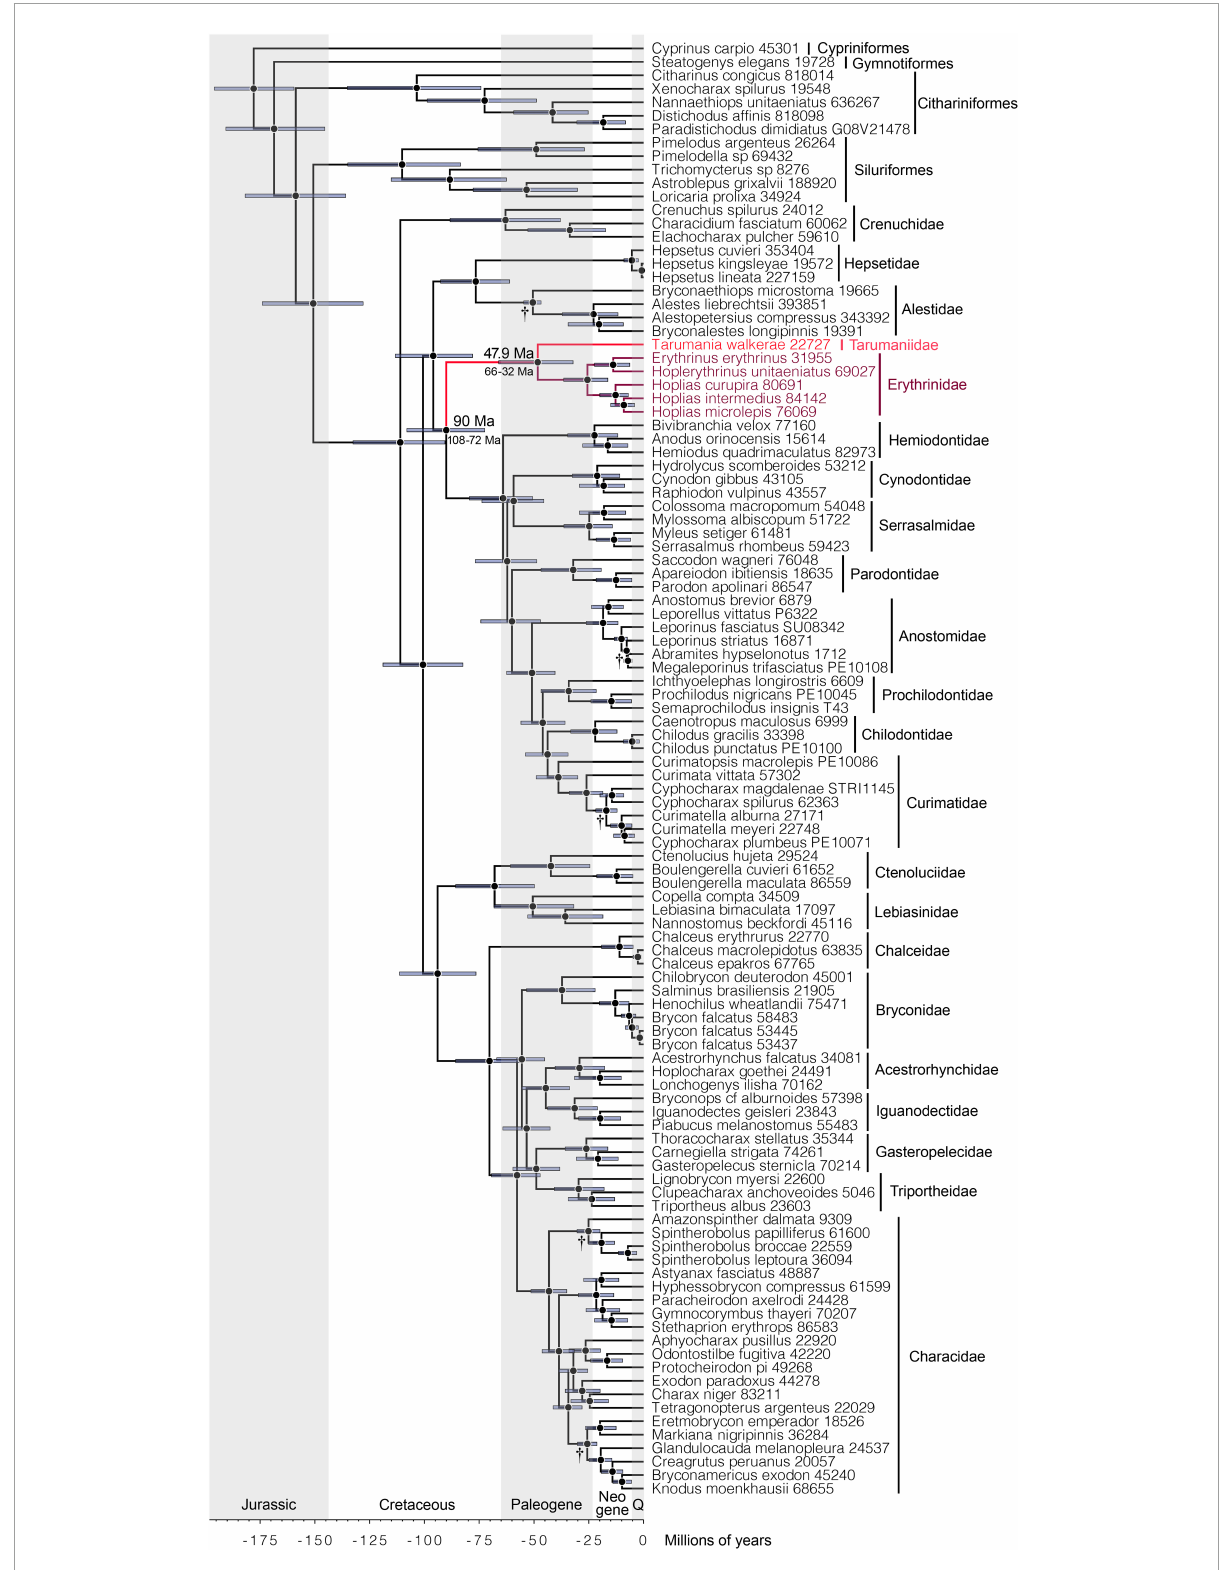
FIGURE4 Fossil-calibrated phylogeny of Characiformes and related taxa based on a Bayesian analysis of ultraconserved elements (90% complete matrix; 172 loci; 50,313 bp) obtained from five fossil calibrations ( † ). Node ages are represented by the highest posterior density (95% HPD; purple bars). Note the divergence time between Erythrinoidea sensu stricto ( s.s. ) (Erythrinidae and Tarumaniidae) and related characoids during the Late Cretaceous (90 Ma; 108–72 Ma 95% HPD), and the divergence time between Erythrinidae and Tarumaniidae during the Paleogene (47.9 Ma; 66–32 Ma 95% HPD). Ma, millions of years ago; Q,